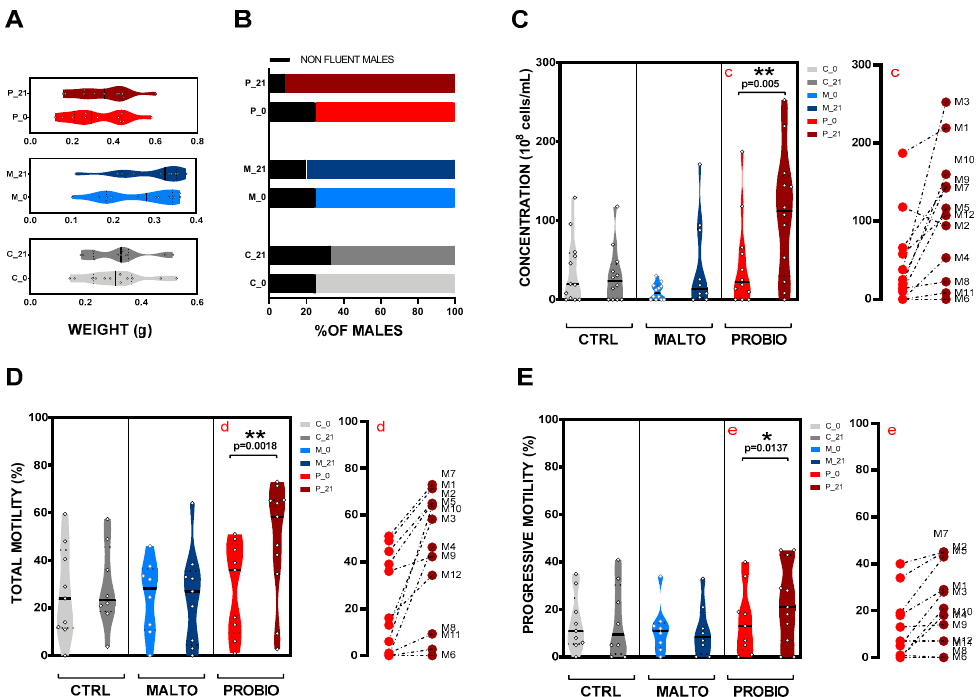
Figure 2. Probiotic mixture supplementation effects on zebrafish males and sperm quality after a cycle of spermatogenesis exposure. ( A ) None of the studied diets modified male total body weight. ( B ) Spermiation ability of studied males before and after the experiment. ( C ) Concentration, ( D ) total motility, and ( E ) progressive motility at 0 and 21 days obtained for each experimental group represented with violin graphs. "C", "M", and "P" refer to the experimental groups: Control, maltodextrin, and probiotics respectively. Furthermore, "c", "d", and "e" are before–after graphs for the PROBIO group where "M#" indicates the number of the male. Asterisks show statistically significant differences: * ( p < 0.0500), ** ( p < 0.0100).